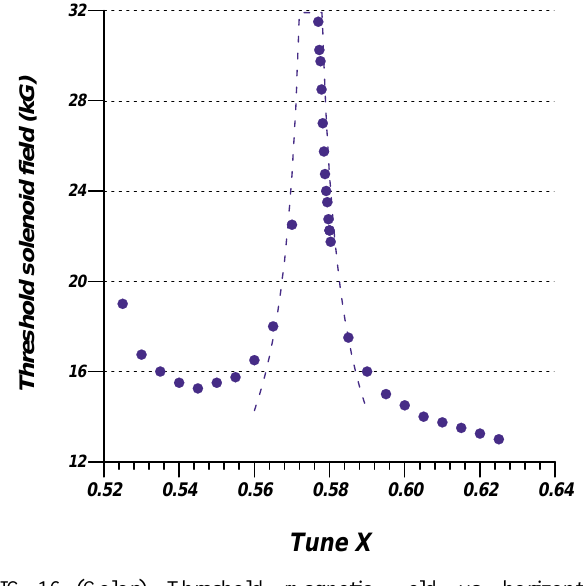
FIG. 16. (Color) Threshold magnetic field vs horizontal tune n x . Dashed line corresponds to B thr ~ 1 (cid:4)